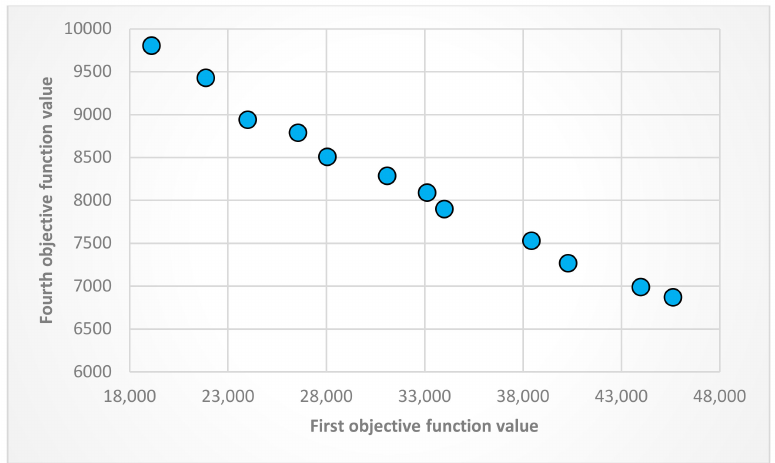
Figure 5. Pareto front of first objective function and fourth objective